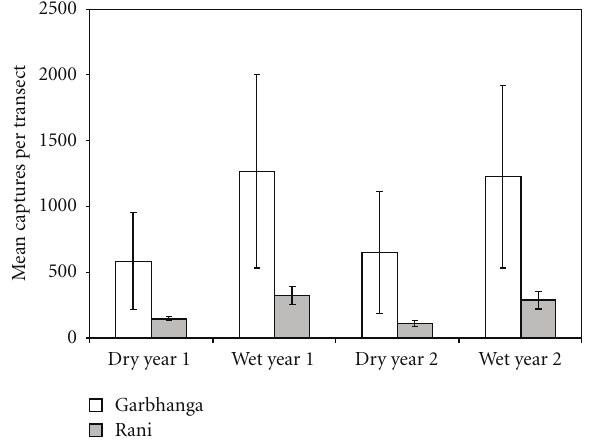
Figure 3: Di ff erences in seasonalabundance of papilionids sampled as individuals during the dry and wet seasons of the two years study period from the 20 fixed transects of study sites S1, S2, S3 in Garbhanga (open bars) and S4 and S5 in Rani (dotted bars).